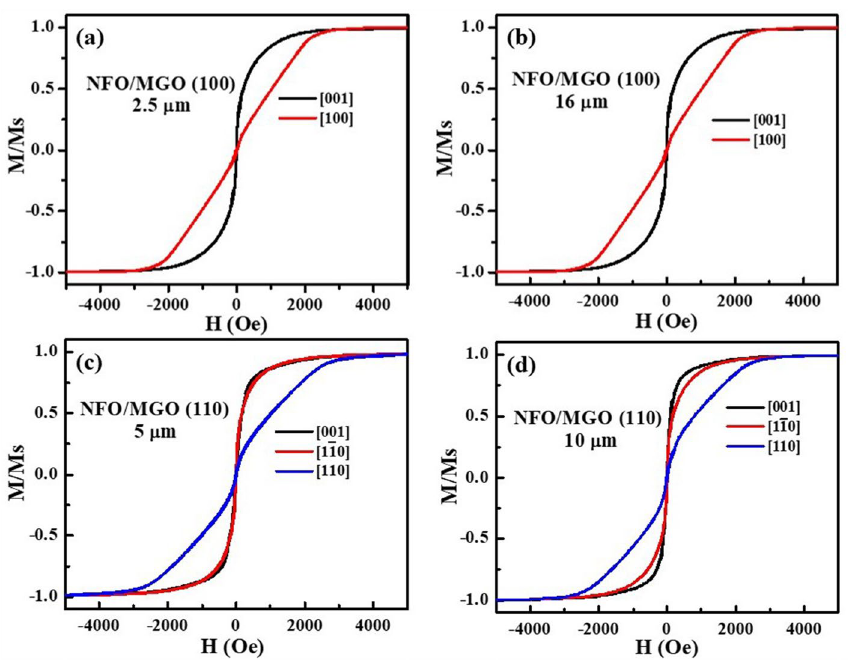
Figure 4. The normalized magnetization (M/M s ) vs magnetic field H for NFO/MGO (100) with thicknesses of ( a ) 2.5 μm and ( b ) 16 μm for in-plane H along [001] direction and for out-of-plane H along [100]. Similar M/M s vs H data for NFO/MGO (110) with thicknesses of ( c ) 5 μm and ( d ) 10 μm for in-plane H along [001] and [1 1 0] directions and for out-of-plane H along [110]